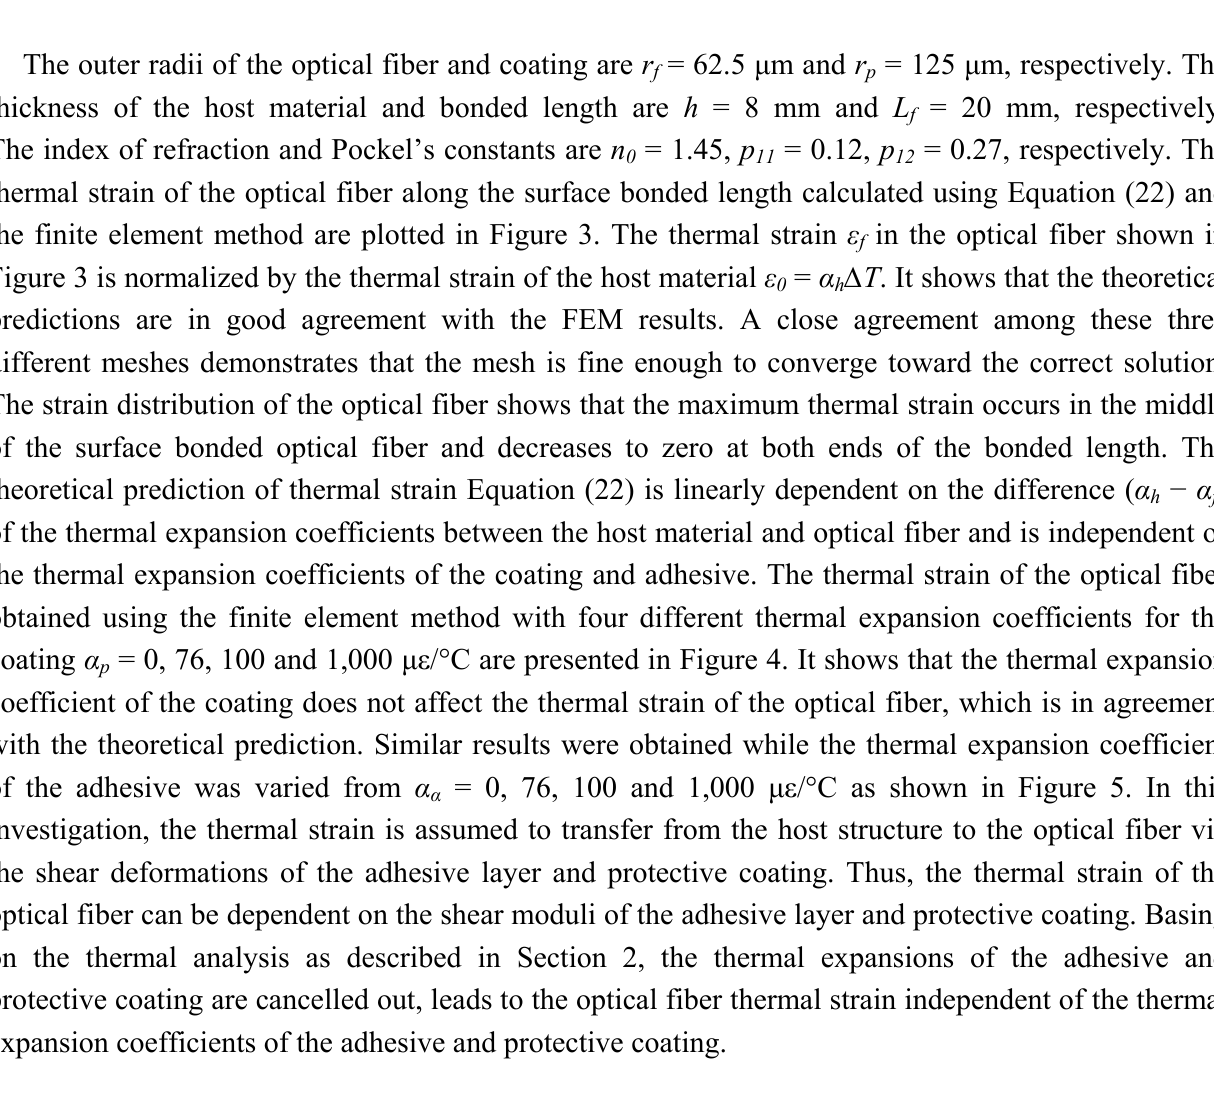
Figure 3. Thermal strain of the optical fiber obtained by Equation (22) and